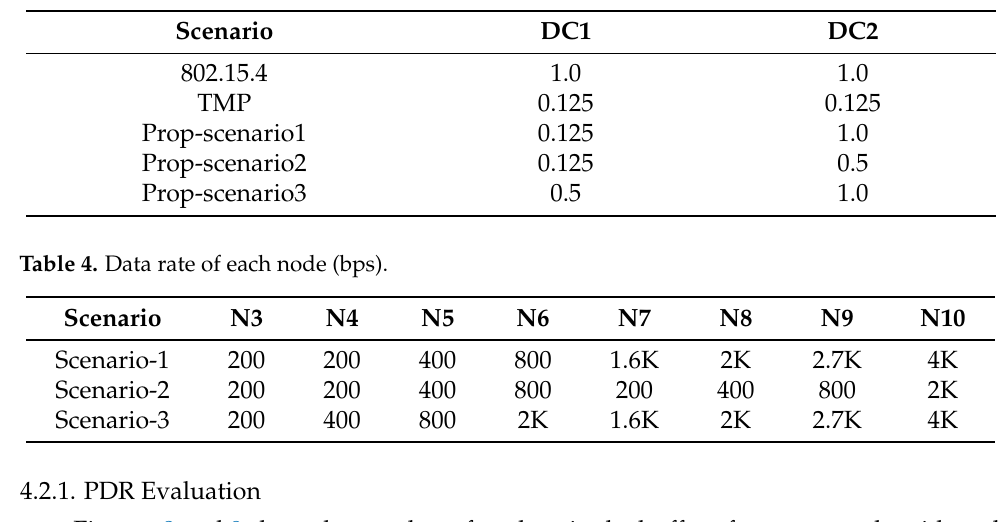
Table 3. Duty-Cycle (DC) for each method.